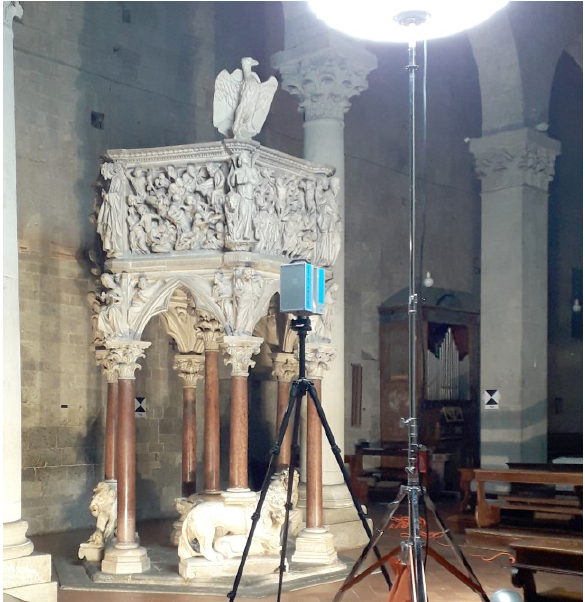
Figure 1 . The ambon during the